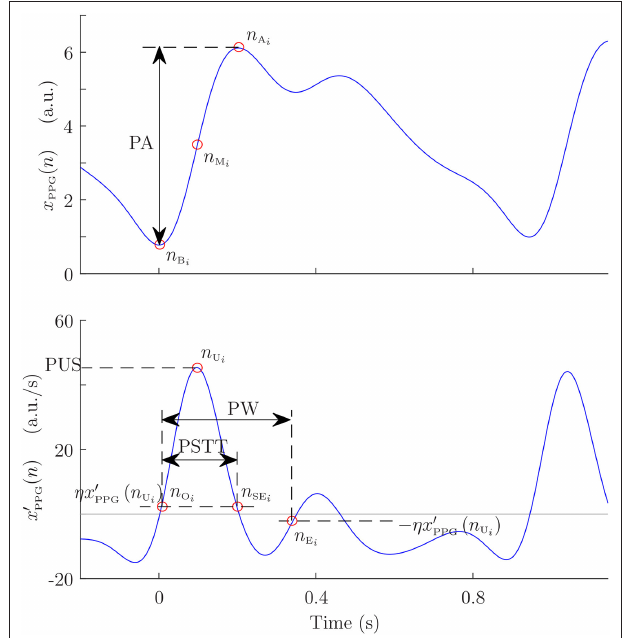
FIGURE 1 | Example of PPG pulse with its automatically detected points, and morphological measures taken from them: pulse amplitude (PA), pulse width (PW), and pulse slope transit time